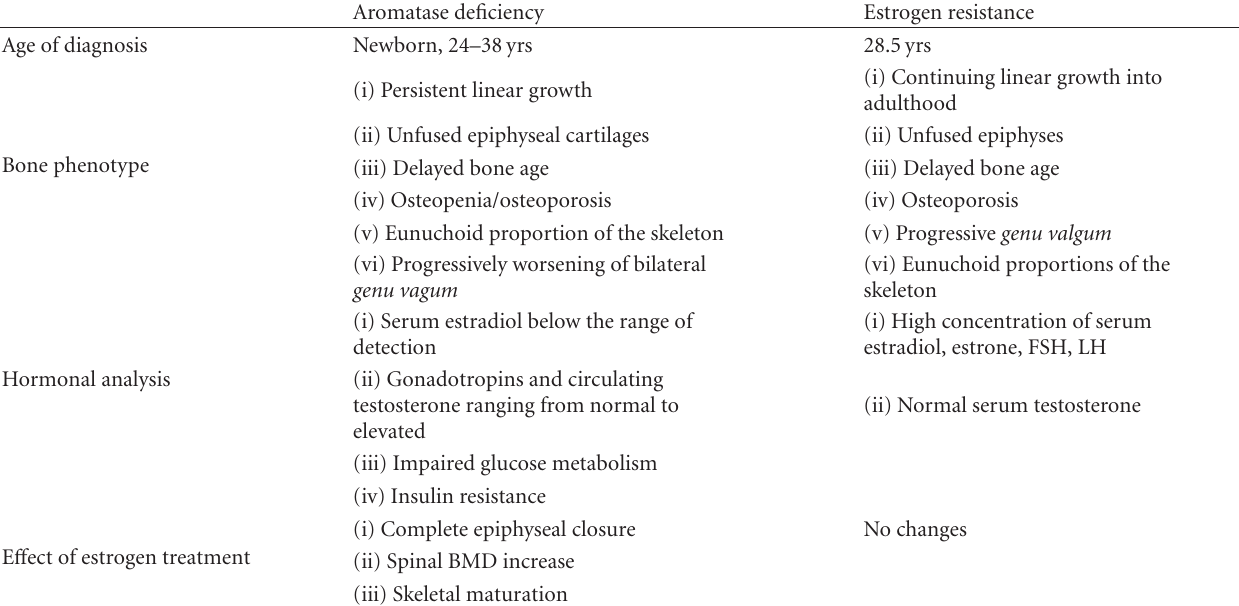
Table 1: Clinical parameters of men with aromatase deficiency or estrogen resistance.